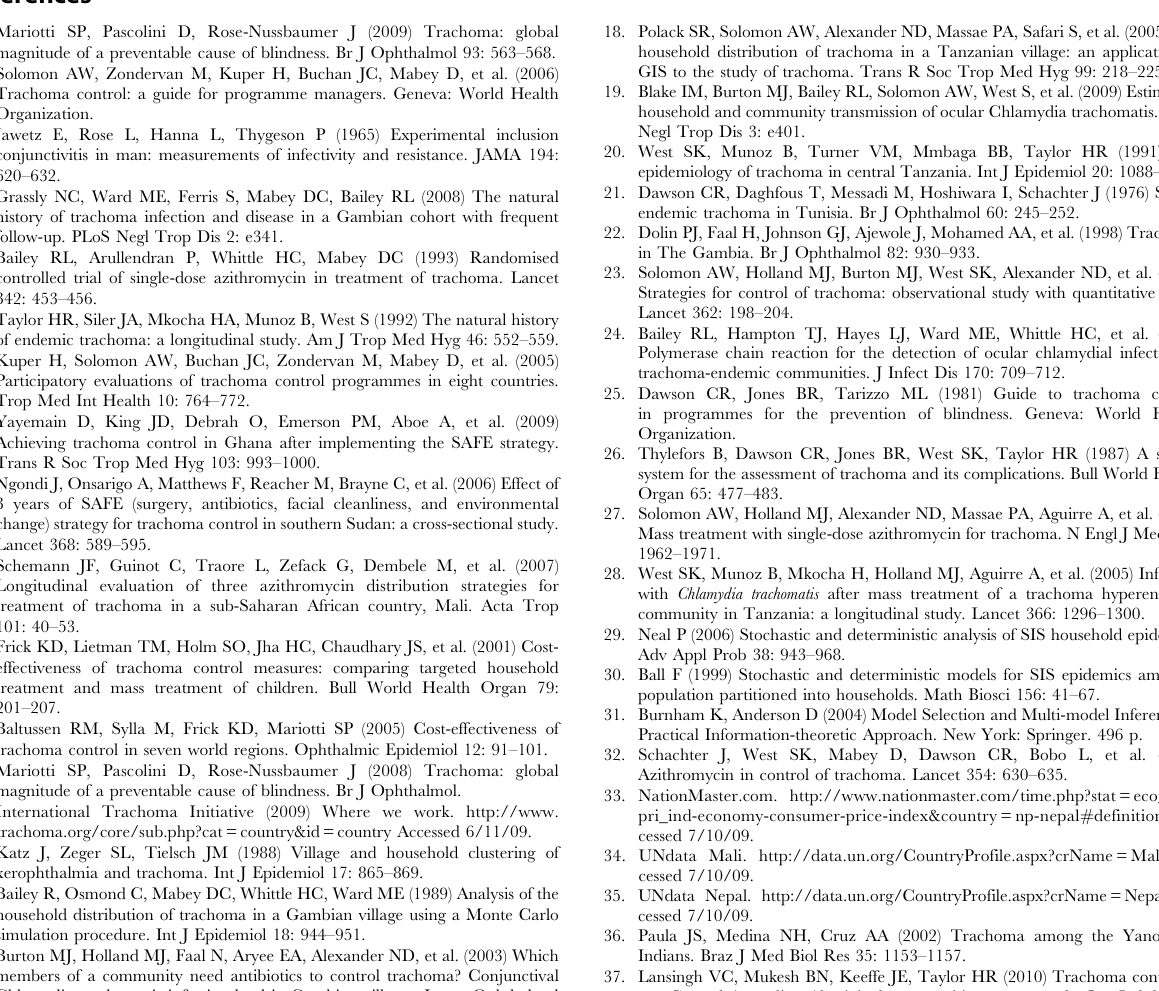
Table S5 Maximum likelihood estimates of the transmission parameters for each of the four populations and nested models. The numbers in square brackets denote 95% confidence